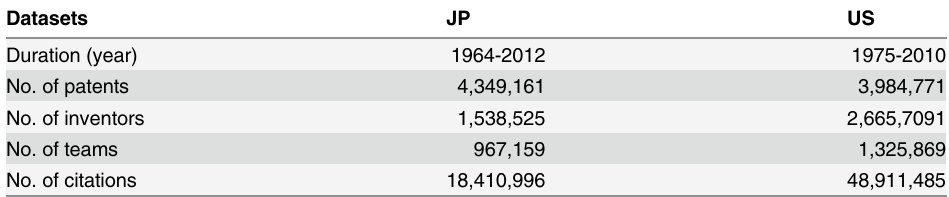
Table 1. Overview of datasets. Datasets used are Japanese (JP) and United States patent data (US). Range of years in which patents were applied for is labeled “ duration. ” In addition, table lists numbers of pat- ents, inventors, teams, and